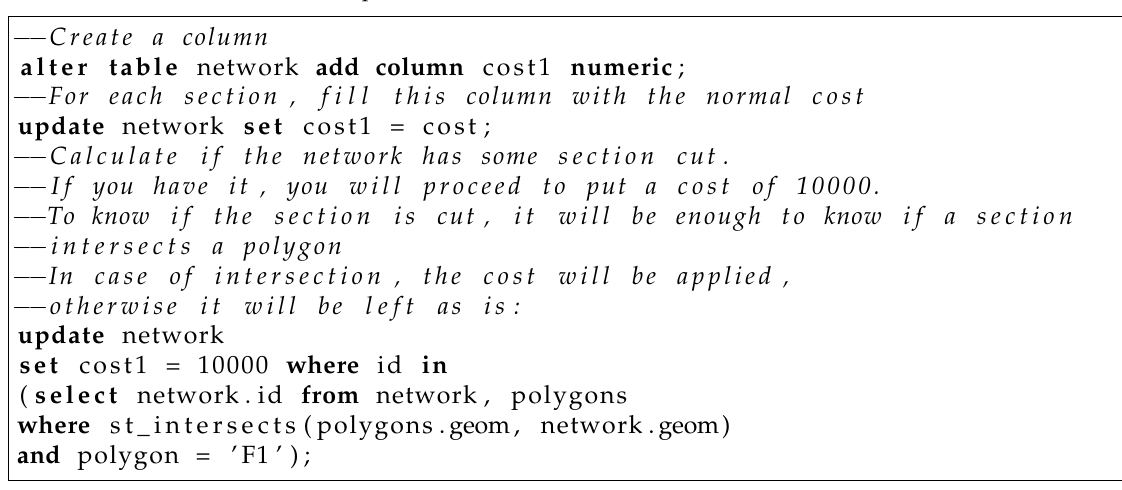
Table 3. example to create one of the columns for the flood scenario